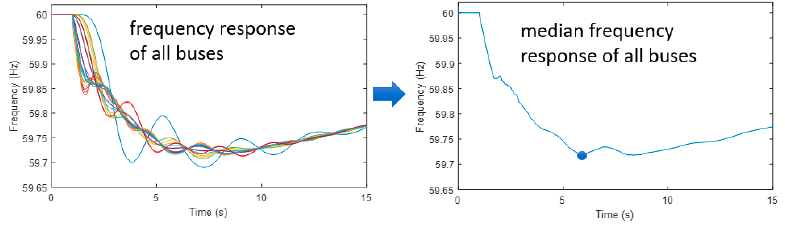
Figure 4. Illustration of the frequency nadir calculation method.